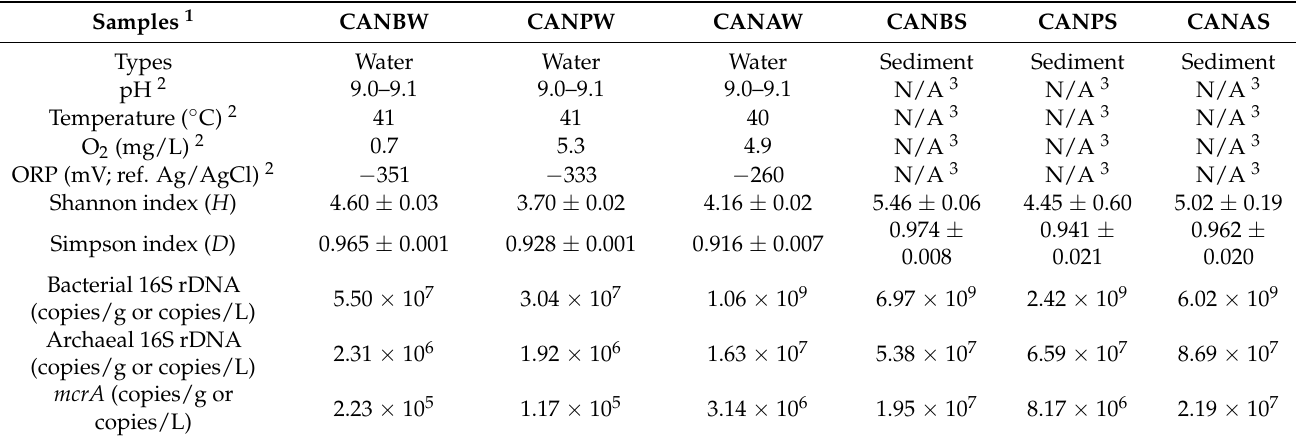
Table 1. In situ physicochemical parameters, alpha diversity and gene abundances in sediment and water samples along the water outflow of La Crouen spring (New Caledonia). Microbial data values are means ± standard deviations of biological